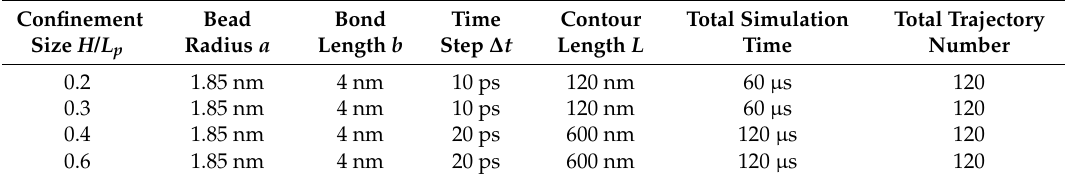
Table 3. Simulation parameters for the confinement of square tubes.